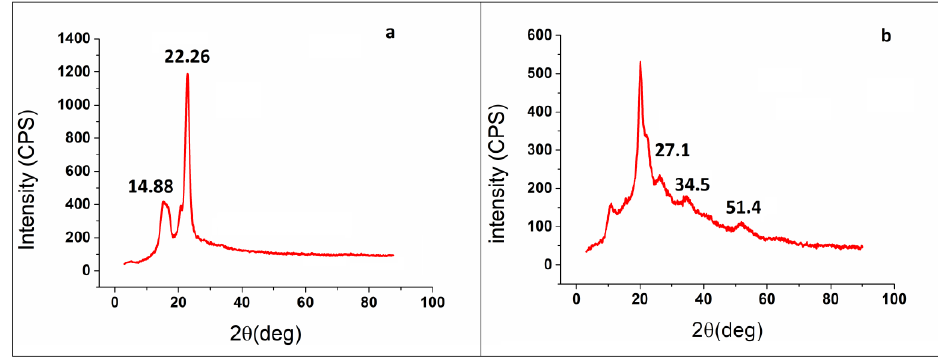
Figure 2. XRD pattern of ( a ) cellulose and ( b ) CSn.